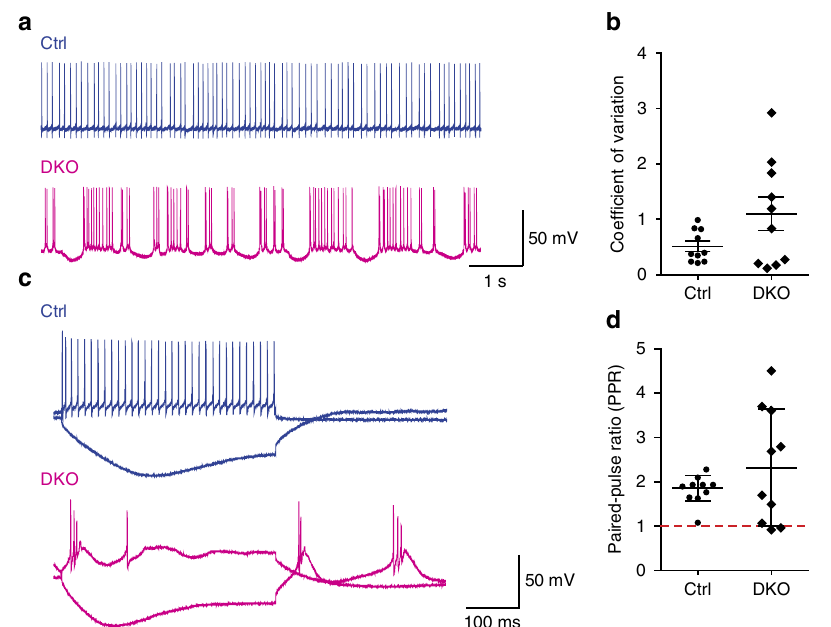
Figure 9 | Aberrant electrophysiological properties in the PCs of Lhx1/5 DKO mutants. ( a ) Typical traces of PC spontaneous firing showing differences in the firing patterns of spontaneous spike between the control PCs (top) and the mutant PCs (bottom). ( b ) Scatter plot showing the coefficient of variation (CV) of interspike intervals of the PCs from the controls or the DKO mutants. ( c ) Representative traces of PC firing in response to depolarizing and hyperpolarizing current injections. Regular repetitive firing and hyperpolarization with inward rectification are shown by the control PCs (top) but bursts of action potentials reminiscent of complex spikes during depolarization and at the termination of a hyperpolarizing response are shown in the mutant PCs (bottom). ( d ) Scatter plot showing the difference in paired-pulse ratio (PPR) between the control PCs and the mutant PCs after delivery of dual stimuli to PFs. Note the greater variability in PPRs in the PCs of the DKO mutants. Data points above the dotted line represent paired-pulse facilitation, while data points below the dotted line represent paired-pulse depression. For all scatter plots, the bars indicate the mean values and 10 PCs from 5 mice were analysed for each